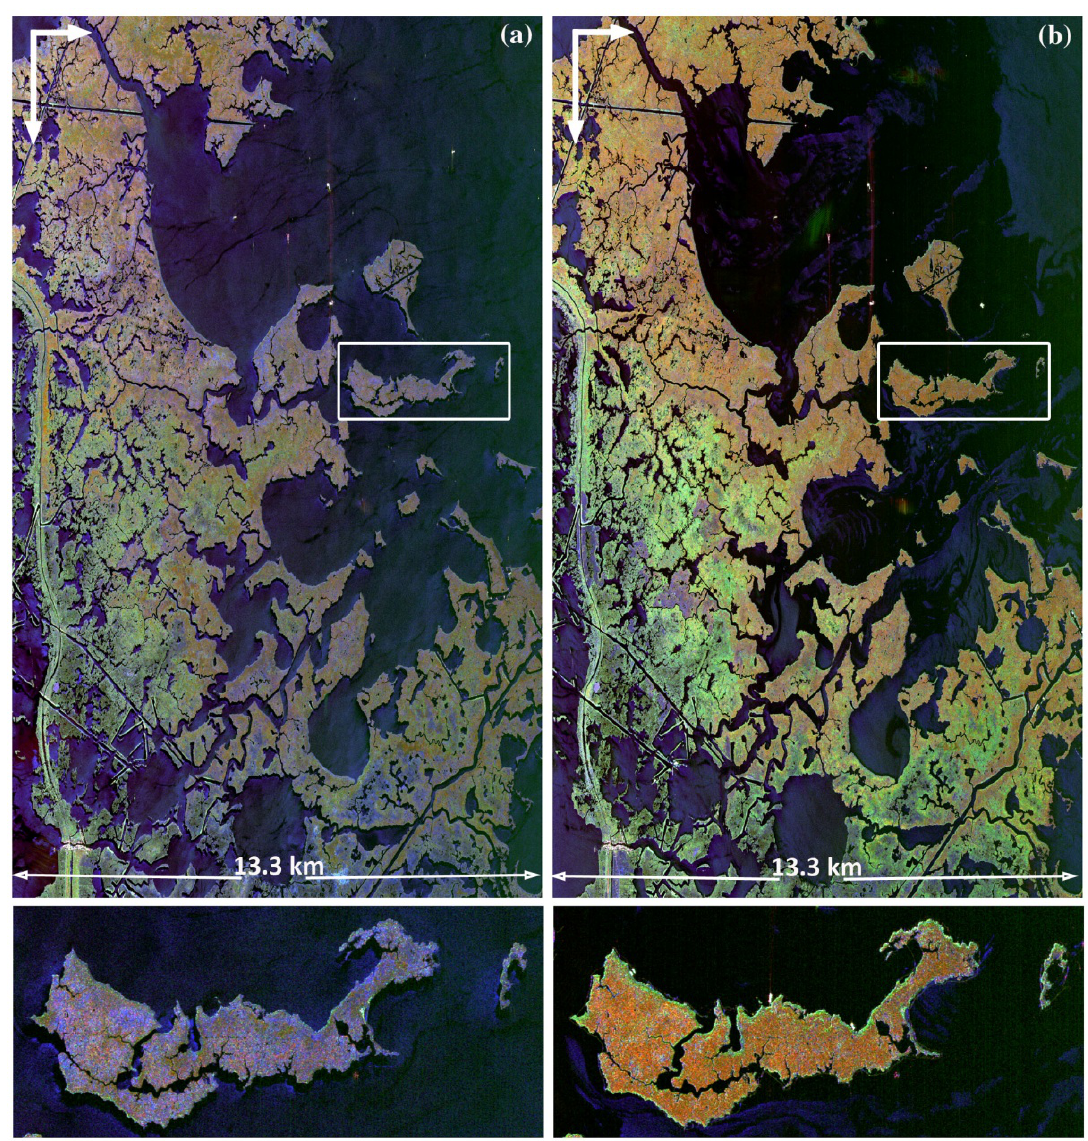
Figure 7. Multi-polarization multilooked (MLC) backscatter intensity data collected in 2009 (a) and 2010 (b) of the MRD flight line, with color composites illustrated as HH (red), HV (green), and VV (blue). The same reference table for color was used in 2009 and 2010